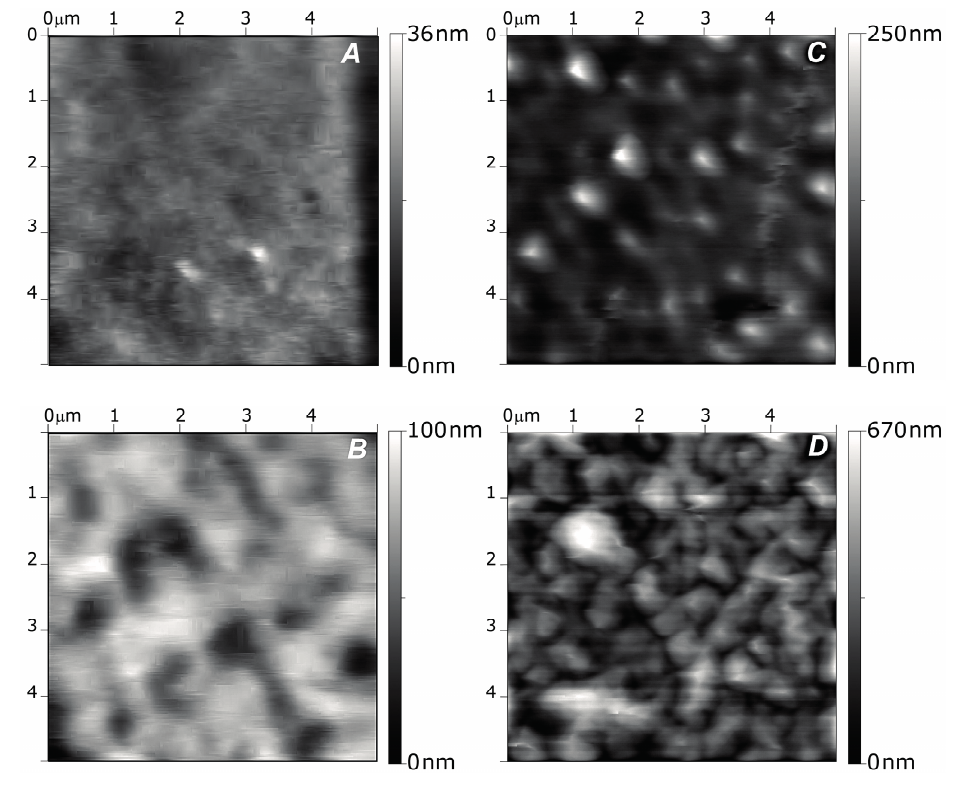
Figure 3. Atomic force microscopy (AFM) images of different alkylamino hydrazide-modified HA/PLL systems with 18 layer pairs: ( A ) linear C6 derivative with DS of 5%; ( B ) branched C10 derivative with DS of 5%; ( C ) linear C10 derivative with DS of 5% and ( D ) linear C10 derivative with DS of 10%. Reproduced with permission from